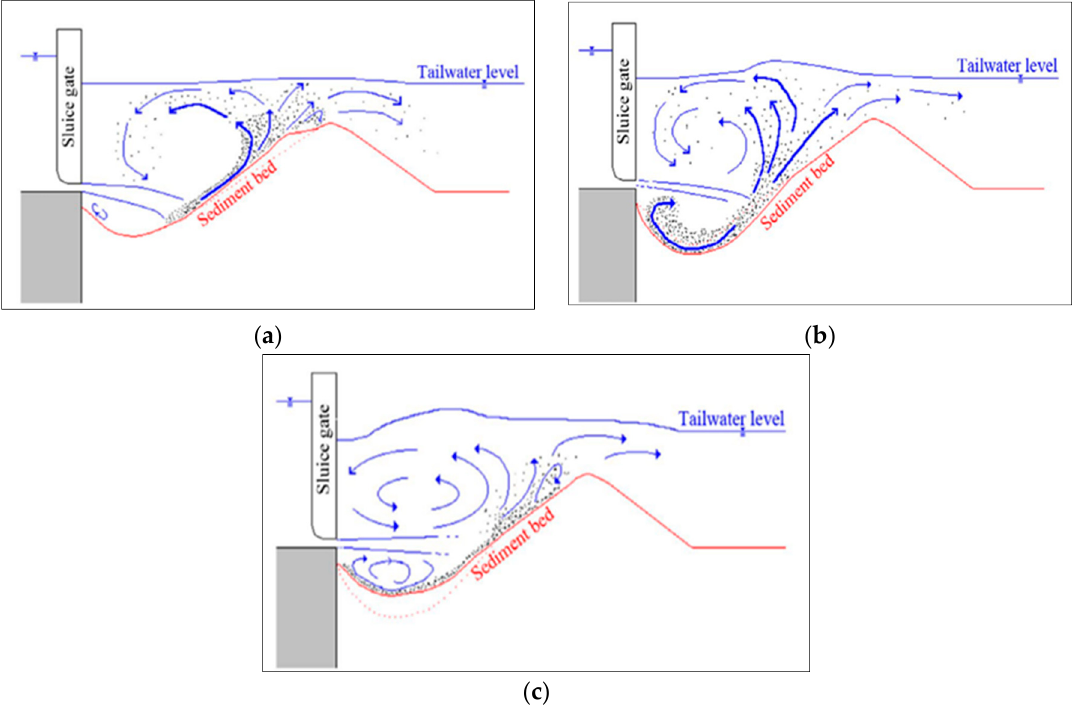
Figure 1. Flow patterns in the downstream of a sluice gate, ( a ) water jets along the bed surface, ( b ) jet rising to the water surface, ( c ) surface jet [5] .